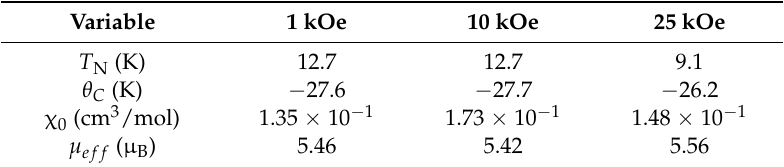
Table 2. Results of the Curie-Weiss fitting in the high temperature regime for LCP- Cmcm sample produced by polyol method.